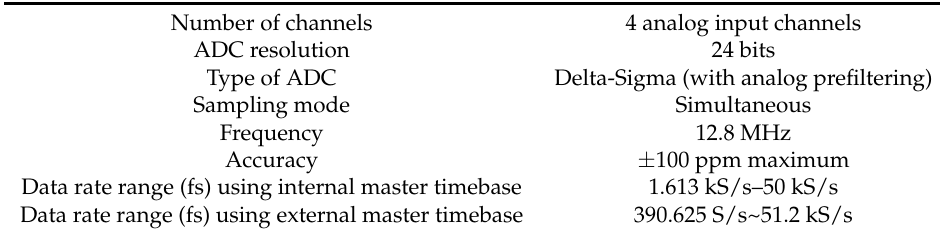
Table A2. The technical parameters of the NI 9239 data acquisition